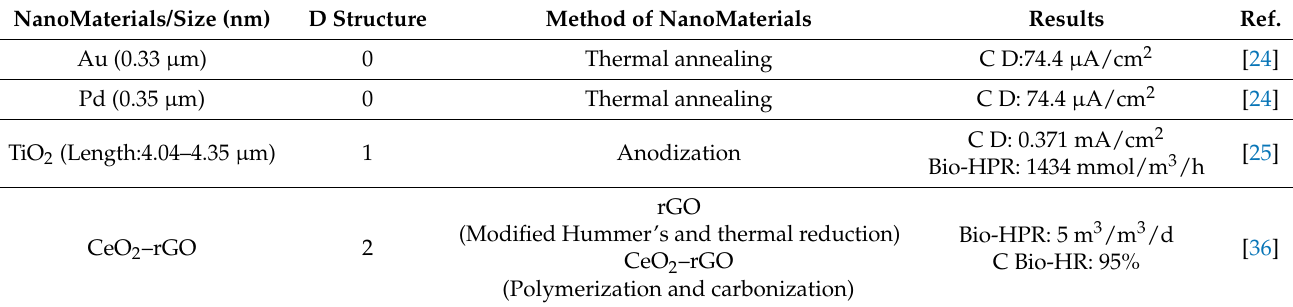
Table 1. Nanomaterials employed for anode electrode and photo-anode electrode in MECs. NanoMaterials/Size (nm) D